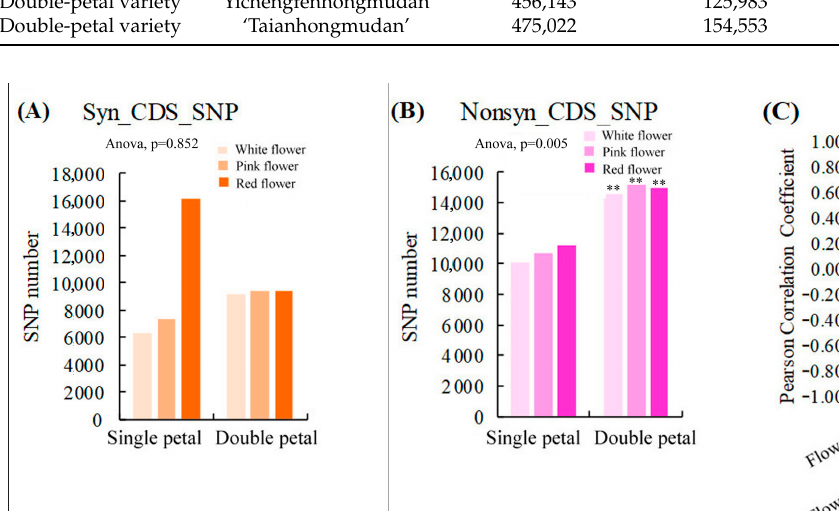
Figure 4. Statistics of synonymous and nonsynonymous SNPs in coding regions and their correla- tion analysis with morphological parameters. ( A ) Statistics of Syn_CDS_SNP number in six varie-